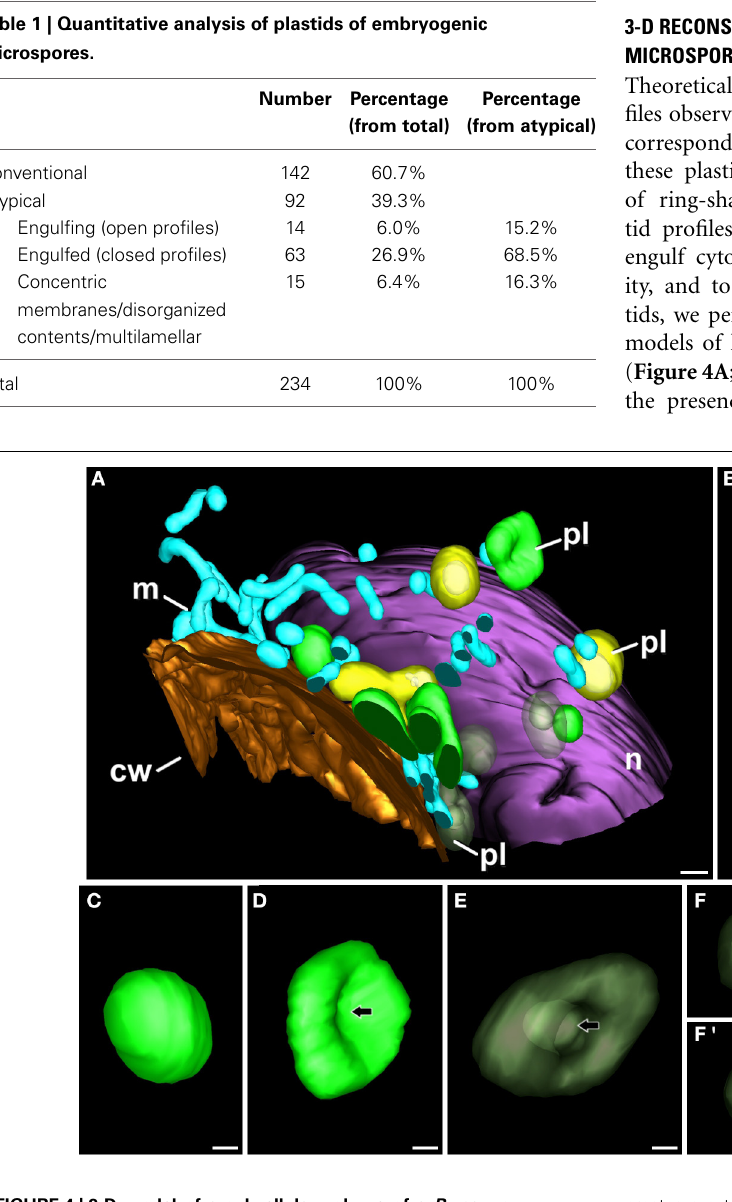
creates a cytoplasmic pocket within the plastid. (F,F’) Cytoplasm-containing plastid where the internal cytoplasm is connected with the outer cytoplasm just by a narrow channel that ends in a small pore at the plastid surface. (F’) is a 90 ◦ turn of this plastid, for a clear visualization of the narrow channel. Arrows point to the pore in (F) and to the narrow channel in (F’) . (G) Round plastid (yellow) with the cytoplasmic contents (white) entirely isolated from the outer cytoplasm. cw, cell wall; m, mitochondrion; n, nucleus. Bars: (A,B) : 500nm; (C–G) :